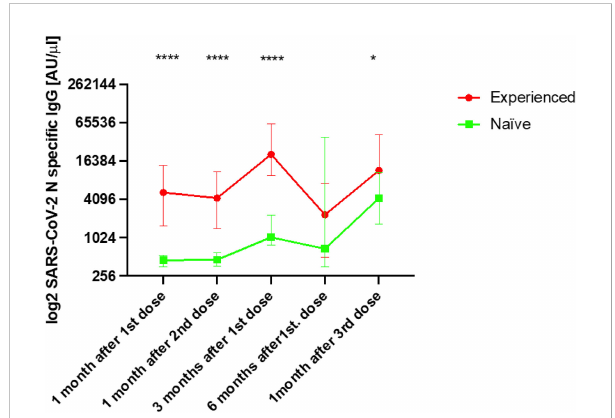
FIGURE 3 Median IgG levels [log2 AU/µl] (arbitrary units/µl [IQR]) against the S1 and RBD antigens of SARS-CoV-2 in both the experienced and naïve elderly groups analysed. *p < 0.05, ****p <